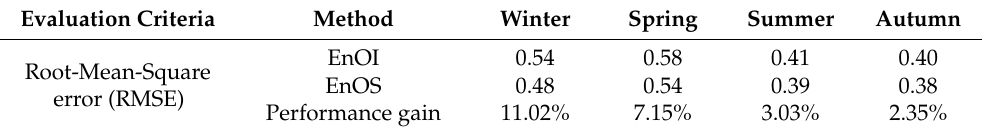
Table 1. RMSEs of EnOI and EnOS in four seasons.